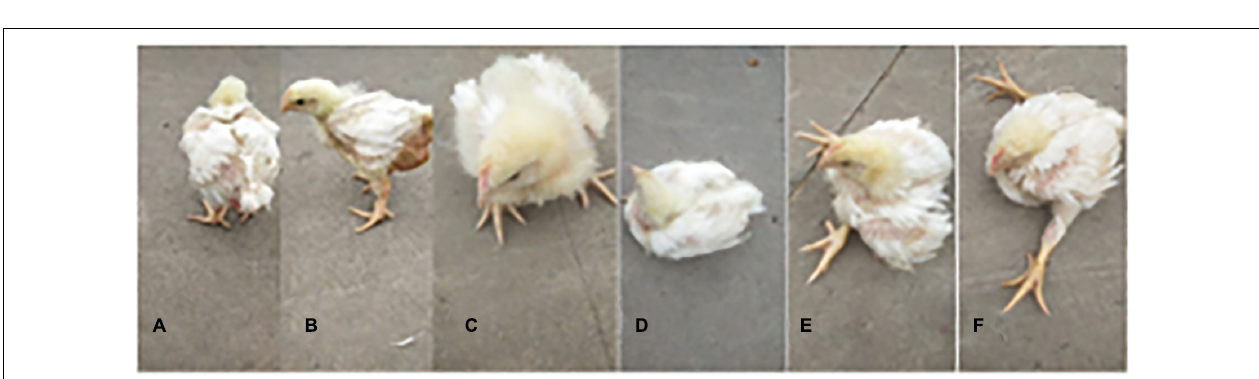
FIGURE 1 | The weight and liver coefficient changes for 3 ∼ 5 weeks of FHN. ∗ indicates a significant difference ( P < 0.05). ∗∗ indicates an extremely significant difference ( P < 0.01).